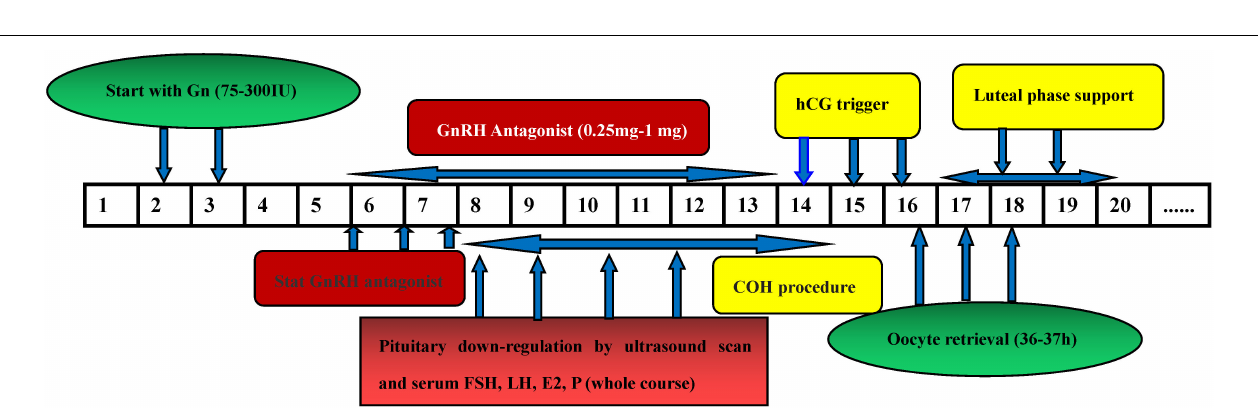
TABLE 1 | Comparison of baseline parameters between the three groups.